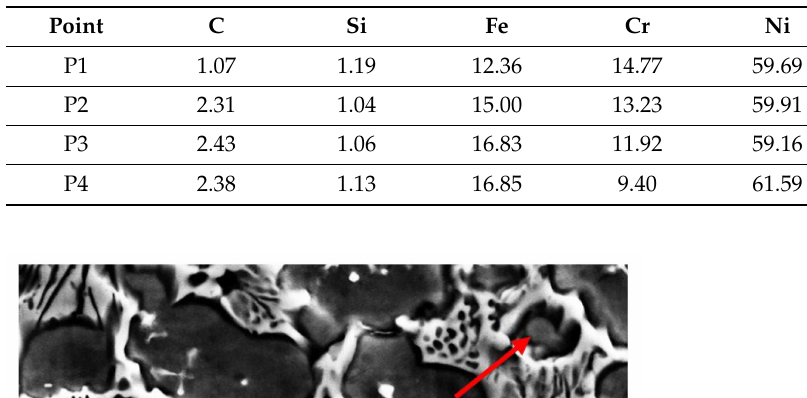
Figure 21. SEM observation of Cladding layer 5# after aging treatment: ( a ) 2 h; ( b ) 8 h; ( c ) 16 h; and ( d ) 24 h. Table 7. Chemical composition of P1–P4 points (wt%).